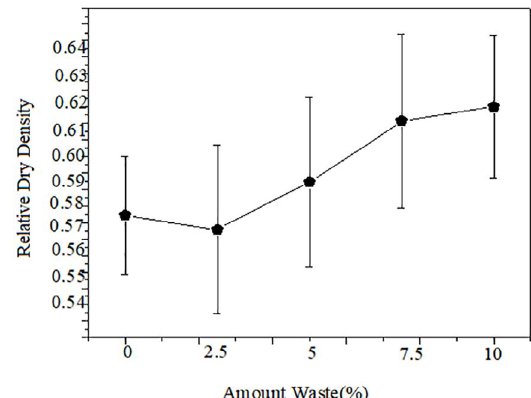
10 wt% SW incorporated clay